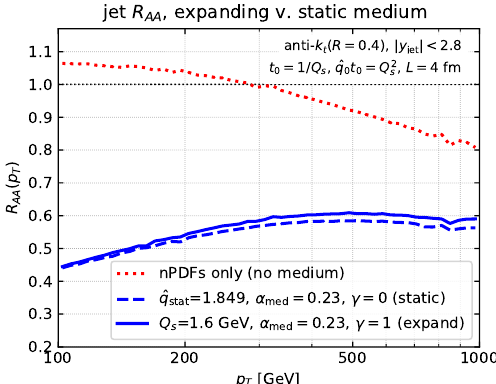
Figure 5. Monte-Carlo simulations for the nuclear modification factor R AA for inclusive jet pro-